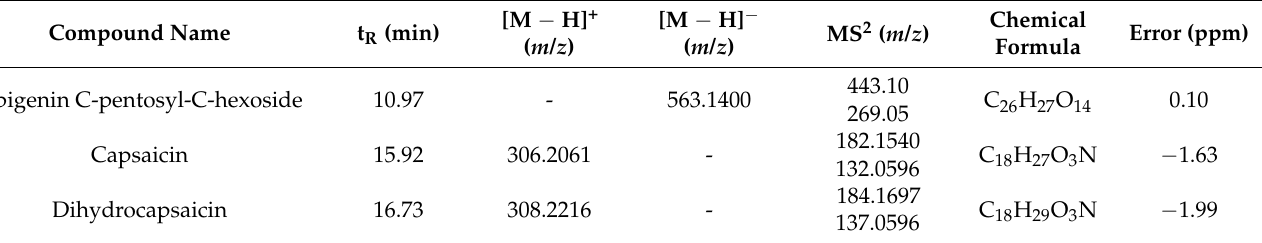
Table 1. Chemical formulas and tentative identification of